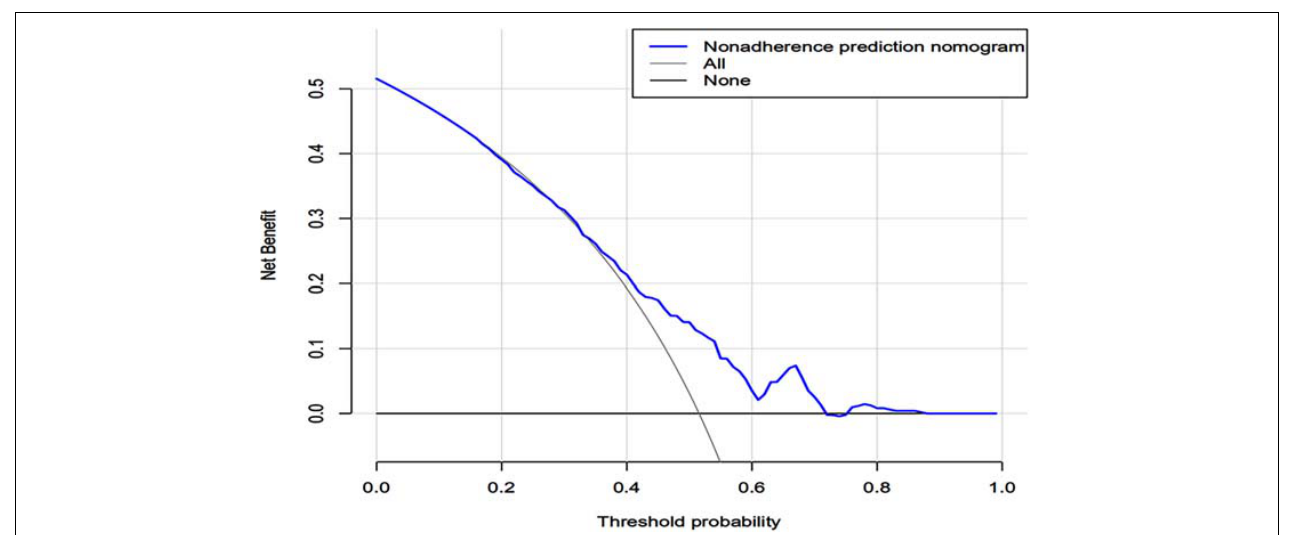
FIGURE 5 | Decision curve analysis of the nomogram. X-axis and y-axis represent threshold probability and net benefit, respectively. For the clinical utility of the nomogram as a diagnostic model for sleep disorders, the net benefit curve is shown in the DCA. When the threshold value of the diagnostic model is between 0.50 and 0.99, the patients will obtain the corresponding net benefit as long as the therapeutic measure is taken. DCA, decision curve analysis.